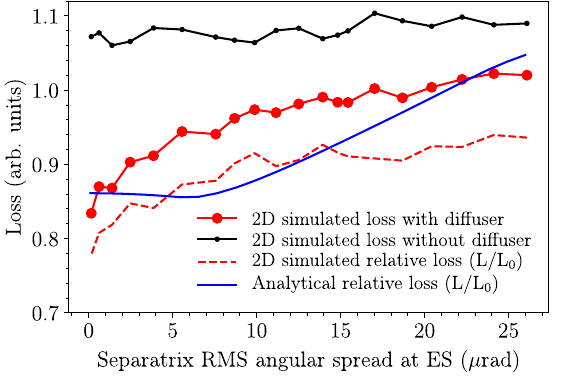
FIG. 15. Relative total beam loss for a 260 - μ m-wide Ta diffuser and 500 - μ m-wide ES, as a function of the separatrix rms angular spread.